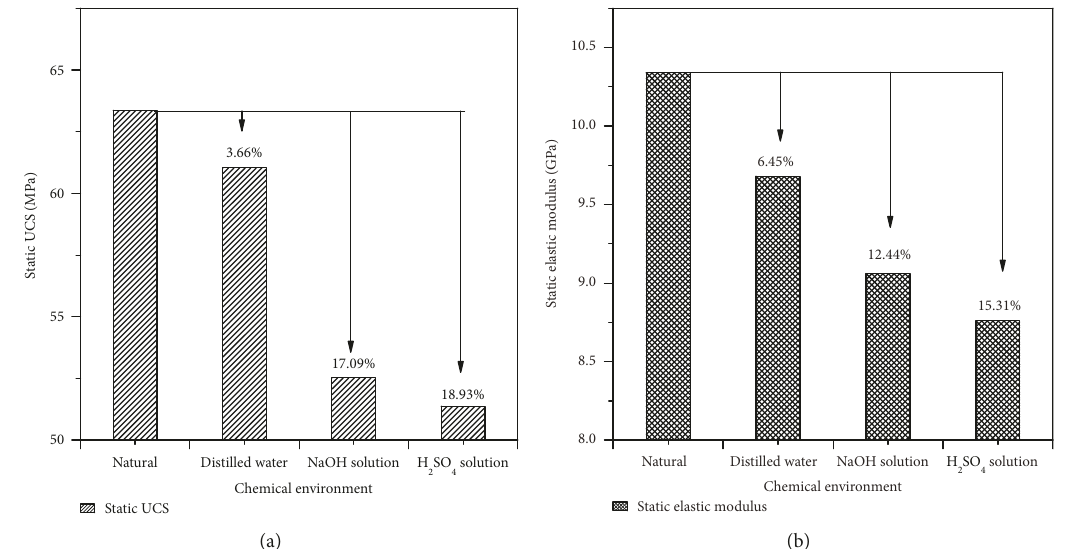
Figure 7: Reduction of UCS and elastic modulus for sandstone specimens subjected to di ff erent chemical solutions.